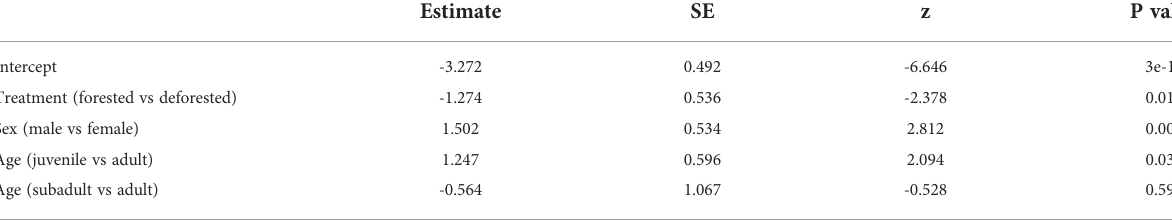
TABLE 3 Best model of viral detection with different categories of land-use change, sex and age. Estimate